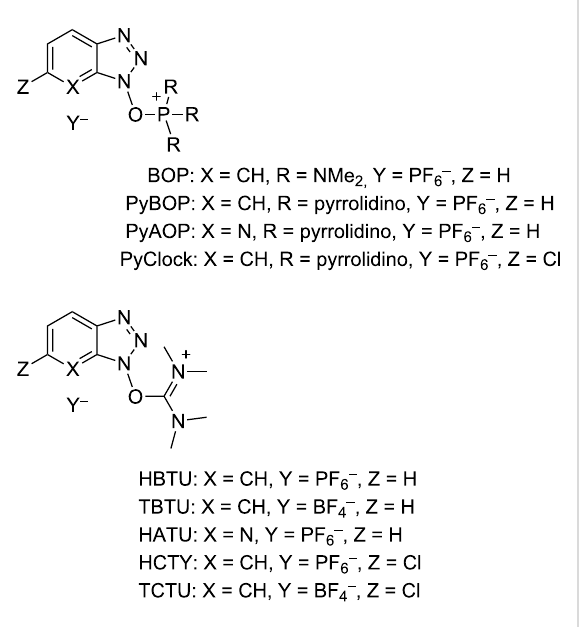
Figure 1: Examples of commercially available reagents for amidation reactions.